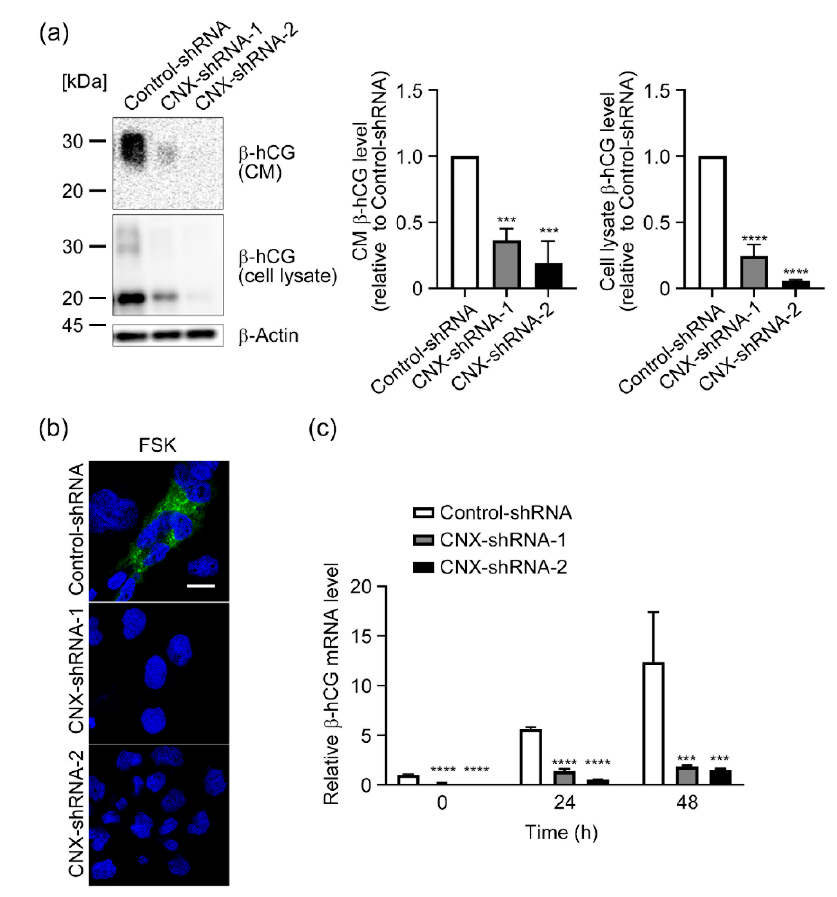
Figure 3. CNX knockdown attenuated FSK-induced β -hCG production in BeWo cells. ( a ) Control- shRNA cells and CNX-knockdown cells (CNX-shRNA-1 and CNX-shRNA-2) were treated with FSK (50 µM) for 72 h, after which cells and conditioned media (CM) were collected and β -hCG levels were analyzed by means of immunoblotting. The graphs show quantification of β -hCG levels in cell lysate and CM. Data are shown as means ± SD of three independent experiments. *** p < 0.001; **** p < 0.0001 vs. Control-shRNA. ( b ) Control-shRNA cells and CNX-knockdown cells (CNX-shRNA-1 and CNX-shRNA-2) were treated with FSK (50 µ M) for 72 h. Intracellular expression and localization of β -hCG were studied by using immunofluorescence microscopy with specific antibodies. Scale bar: 20 µm. ( c ) Control-shRNA cells and CNX-knockdown cells (CNX-shRNA-1 and CNX-shRNA-2) were treated with FSK (50 µM) for 48 h. Total RNA was collected at the indicated time points, and then RT-qPCR was performed for β -hCG as described in Materials and Methods. Data are shown as means ± SD of three independent experiments. *** p < 0.001; **** p < 0.0001 vs. Control-shRNA at each time point.